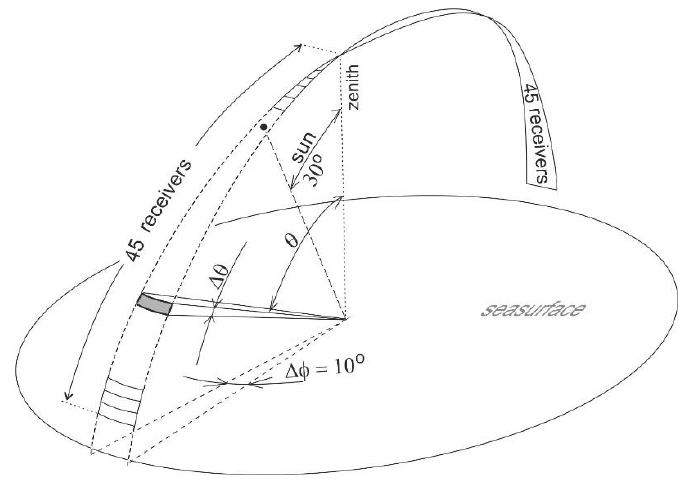
Figure 1. Geometry of virtual measurement of upward radiance. Table 1. The angular boundaries of individual sectors and the sector dimensions expressed as solid angle values.